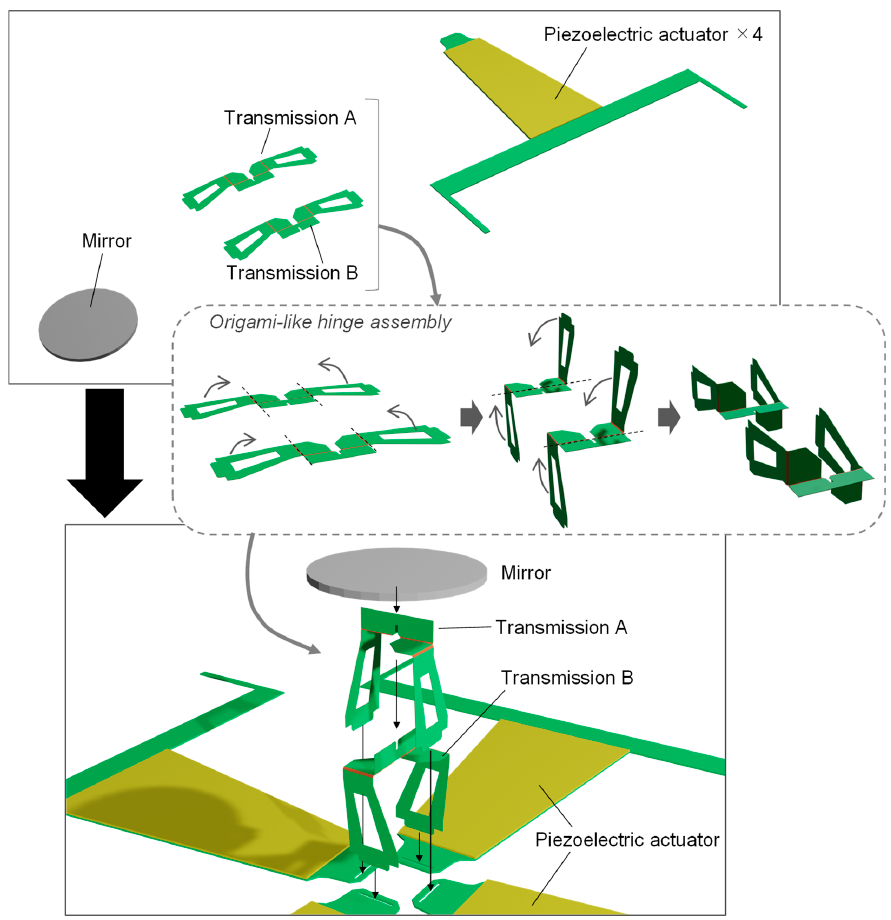
Figure 5. Assembly of the developed scanner.